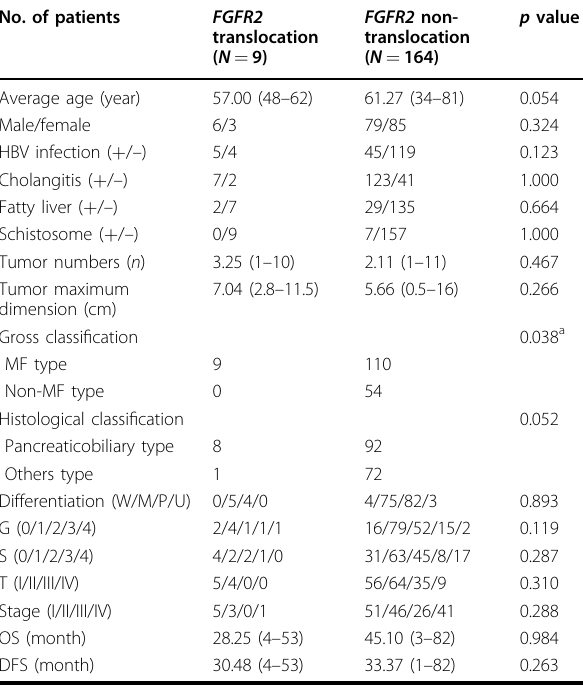
Table 1 Clinicopathologic characteristics of FGFR2 translocation and non-translocation in